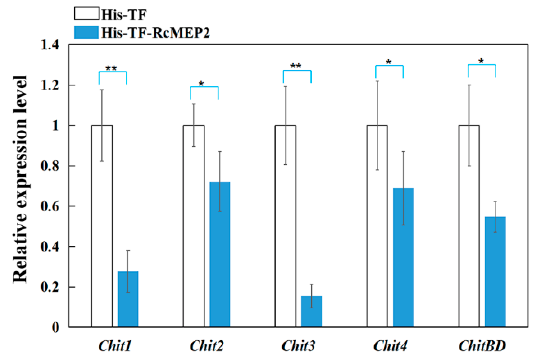
Figure 9. Inhibition of RcMEP2 on the transcription of wheat chitinases. Both samples were derived from the susceptible wheat cv. Wenmai 6 leaves at three days after inoculation with the His-TF-RcMEP2 and the His-TF (CK) at a concentration of 5 µM. The wheat Actin gene was used as an internal control to normalize the data. Error bars (SE) were calculated based on three replicates. Asterisk * indicates significant difference (** p < 0.01 or * p < 0.05, t -test) between His-TF-RcMEP1 treatment and His-TF (CK) treatment.